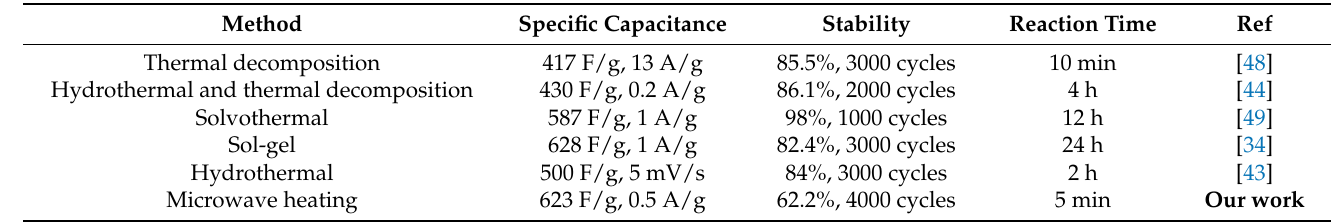
Figure 6. ( a ) CV graph indicating the capacitive contribution of NiO x @GR-C2 at 20 mV/s. ( b ) The calculated b values at different scan rates. ( c ) A stacked bar graph showing the percentage of the total capacitance attributed to the diffusion-limited and capacitive contributions. Table 1. Comparison of the electrochemical properties of NiO x @GR prepared through microwave heating with previously reported approaches.